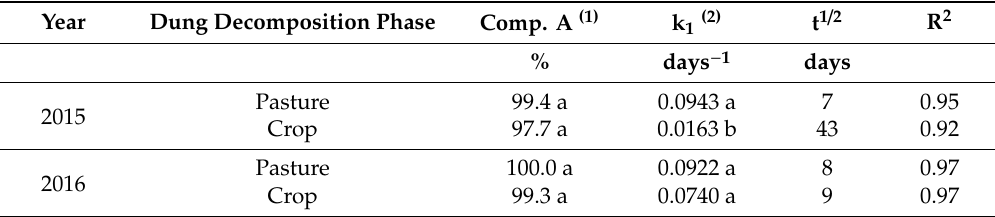
Table 5. Parameters of simple exponential models fitted to potassium release rates from sheep dung, calculated half-life values (t 1 / 2 ), and coe ffi cient of determination (R 2 ) at di ff erent decomposition phases during the 2015 and 2016 annual cycle of a no-till integrated soybean-sheep production system. Results are the averages of low and moderate grazing intensities.